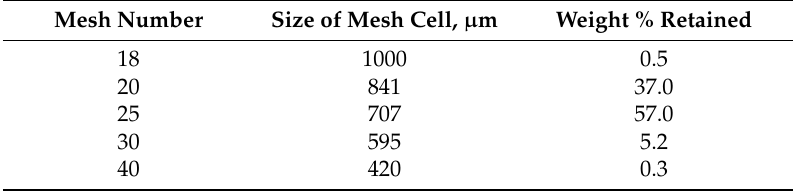
Table 4. Grain size distribution for CarboProp NRT 16/30 by sieve-based